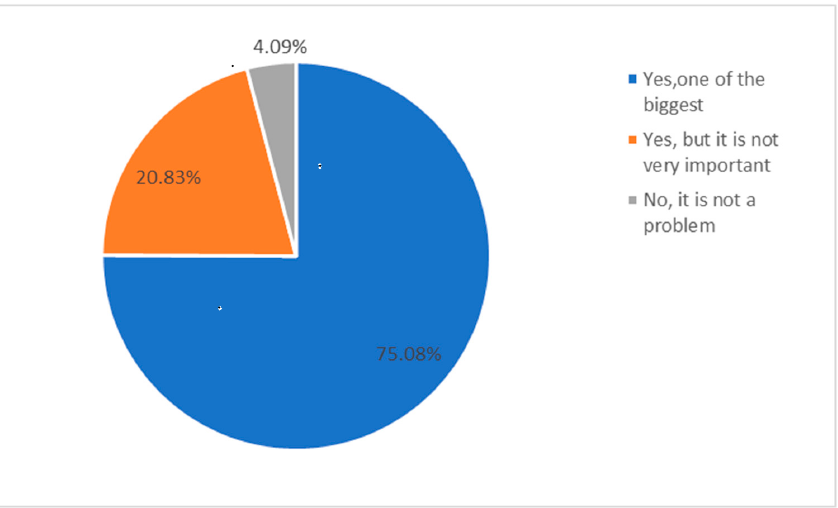
Figure 3. Responses to the question, “Do you think that food waste is a problem for the society?”